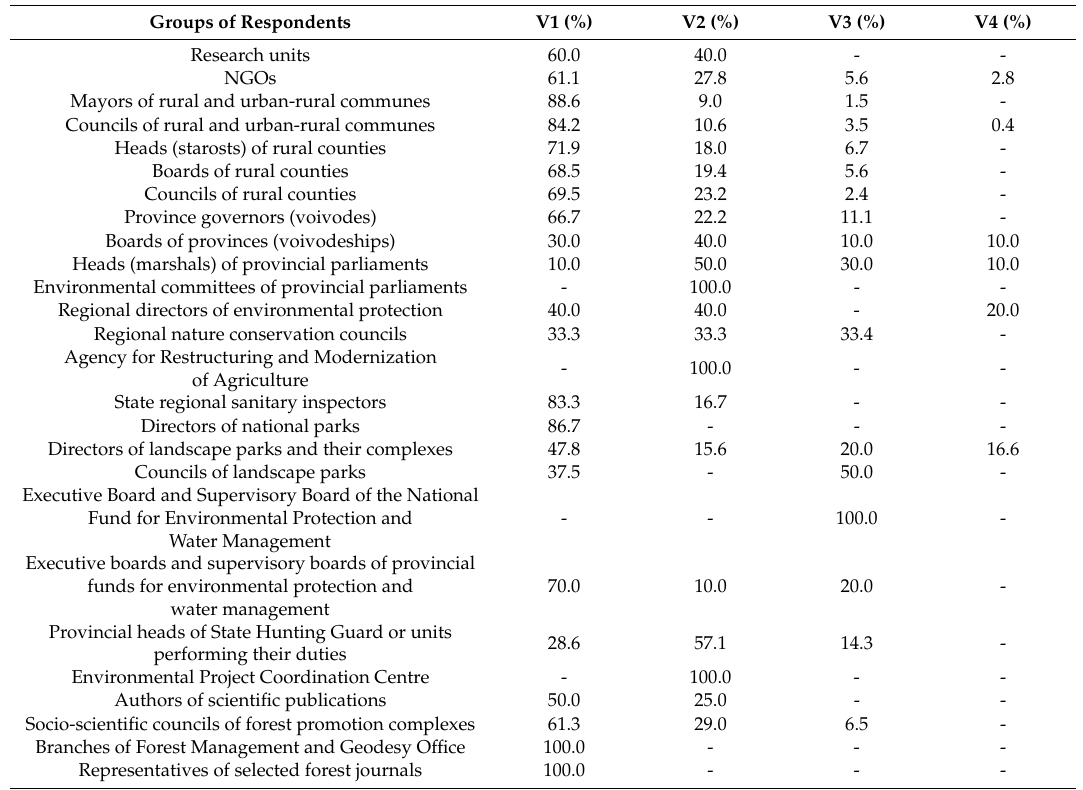
Table 3. The four most frequently chosen variants to answer Question 2 (who should be responsible for the areas and objects of protected nature in the State